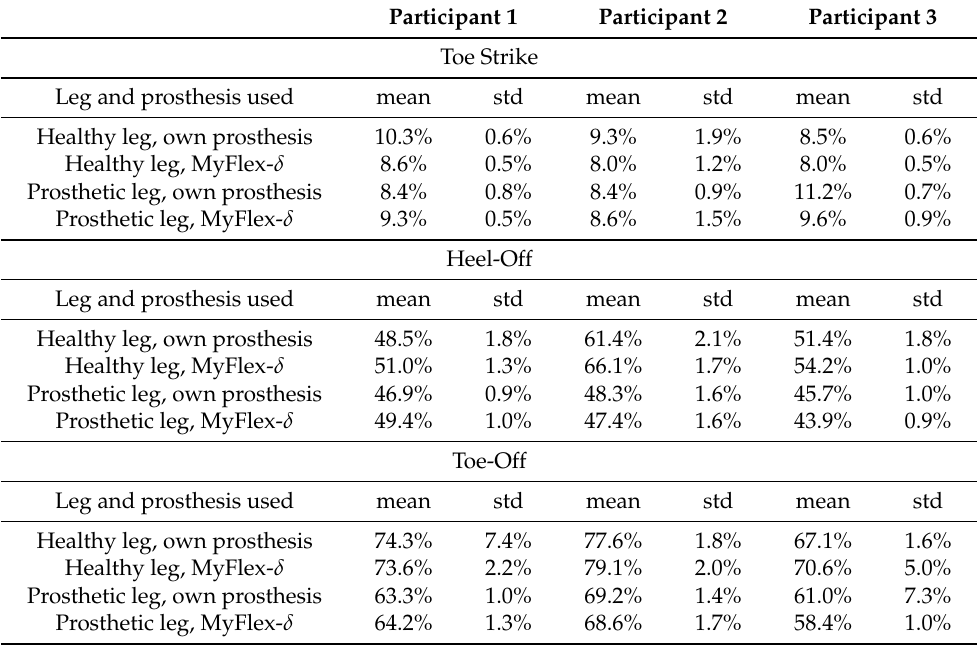
Table 8. Stance phase events. Mean values (mean) and standard deviations (std) are calculated from 50 gait cycles.